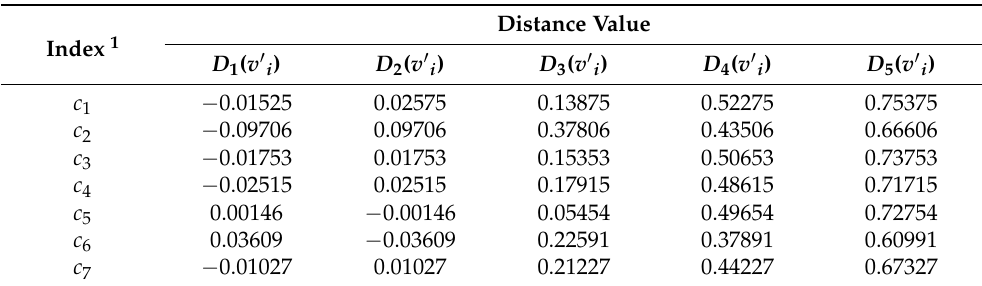
Table 4. Distances [ D j ( v (cid:48) i )] between the evaluation indices and the classical domain for sampling point S1.